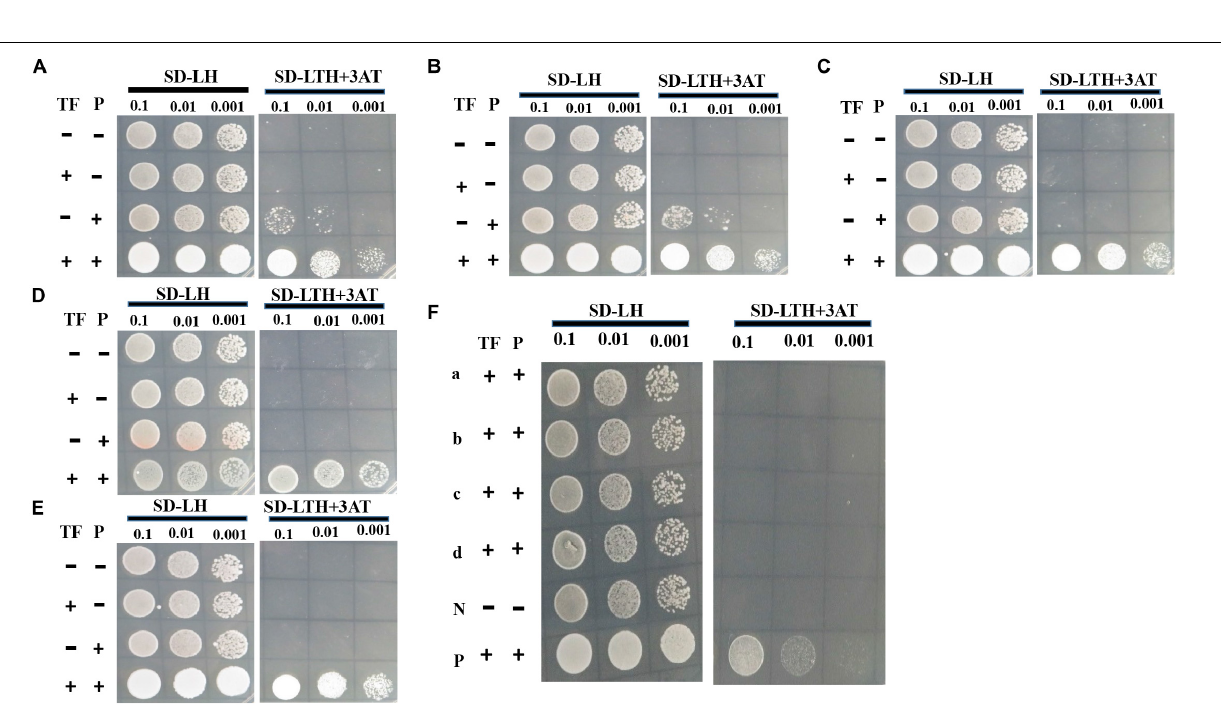
Frontiers in Microbiology |